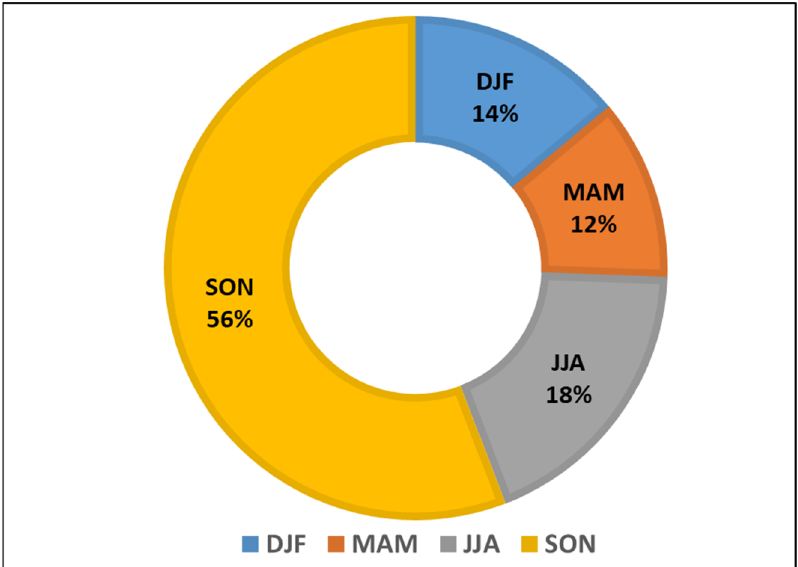
Figure 2. Disaster declarations per season (1956–2020): Winter (DJF: December-January-February; Spring (MAM: March-April-May); Summer (JJA: June-July-August); Falls (SON: Septem- ber-October-November) Source: FEMA Disaster Declaration Summary 2020. Last Updated: 19